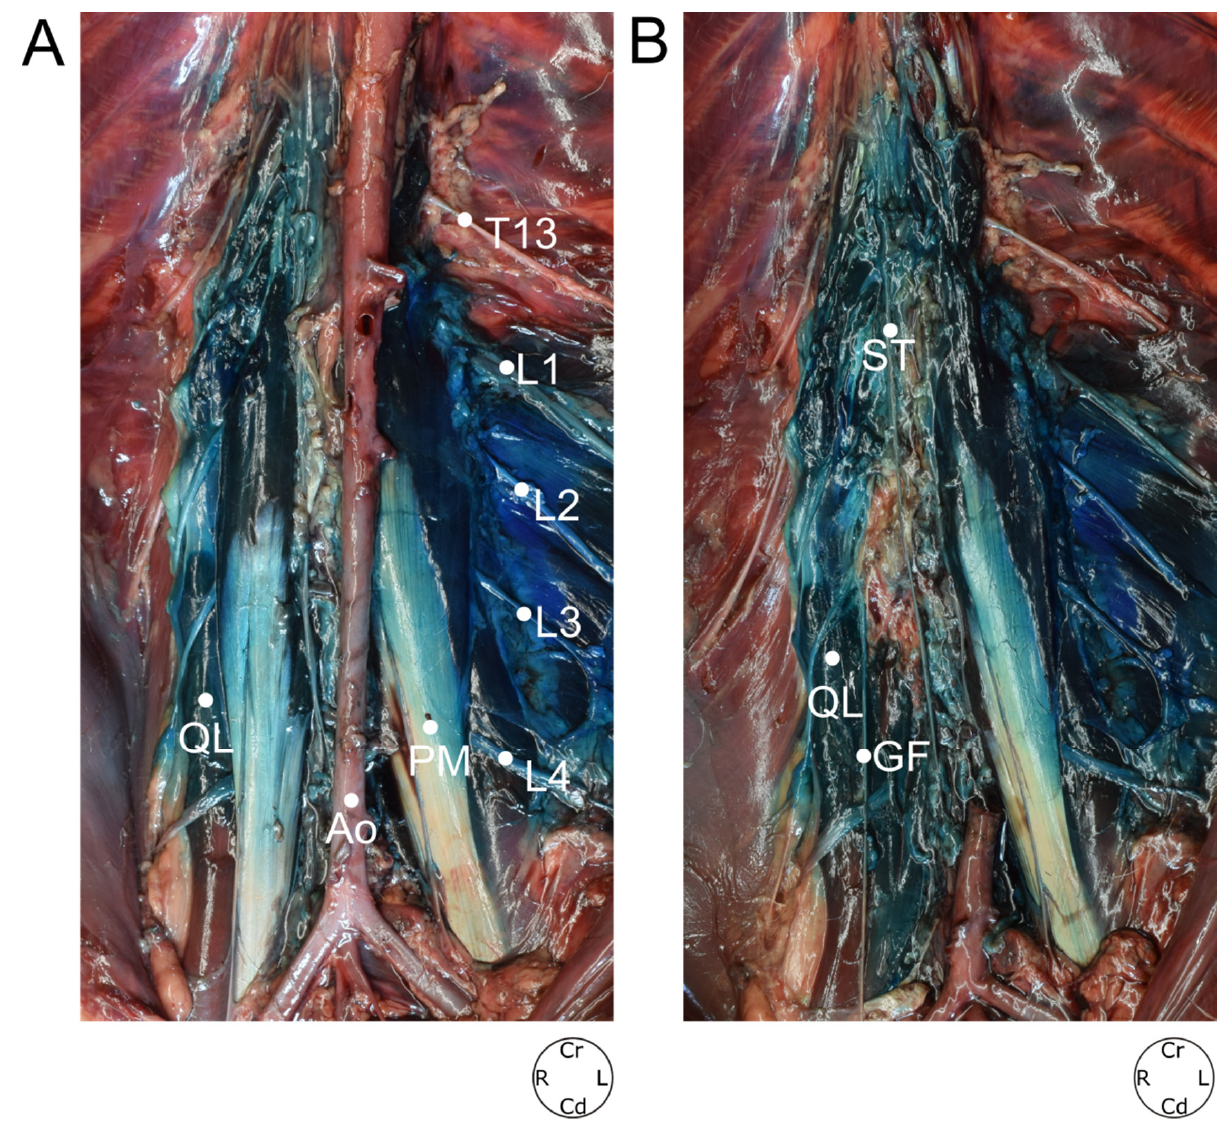
Figure 8. ( A ) Distribution of the dye through the quadratus lumborum and psoas minor muscles and spinal nerves. ( B ) Distribution of the dye through the lumbar sympathetic trunk after removing the right psoas minor muscle and the caudal aorta. T13; L1; L2; L3; L4, ventral branches of T13, L1, L2, L3 and L4 nerves respectively; GF, genitofemoral nerve; ST, sympathetic trunk; Ao, aorta; QL, quadratus lumborum muscle; PM, psoas minor muscle; Cr, cranial; Cd, caudal; R, right; L, left.